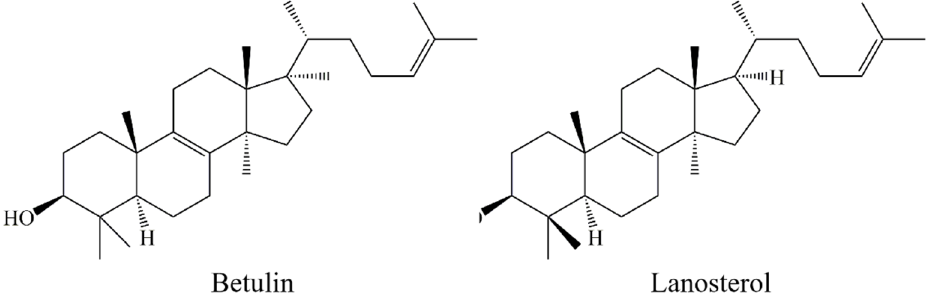
Figure 7. The chemical structures of betulin and lanosterol.